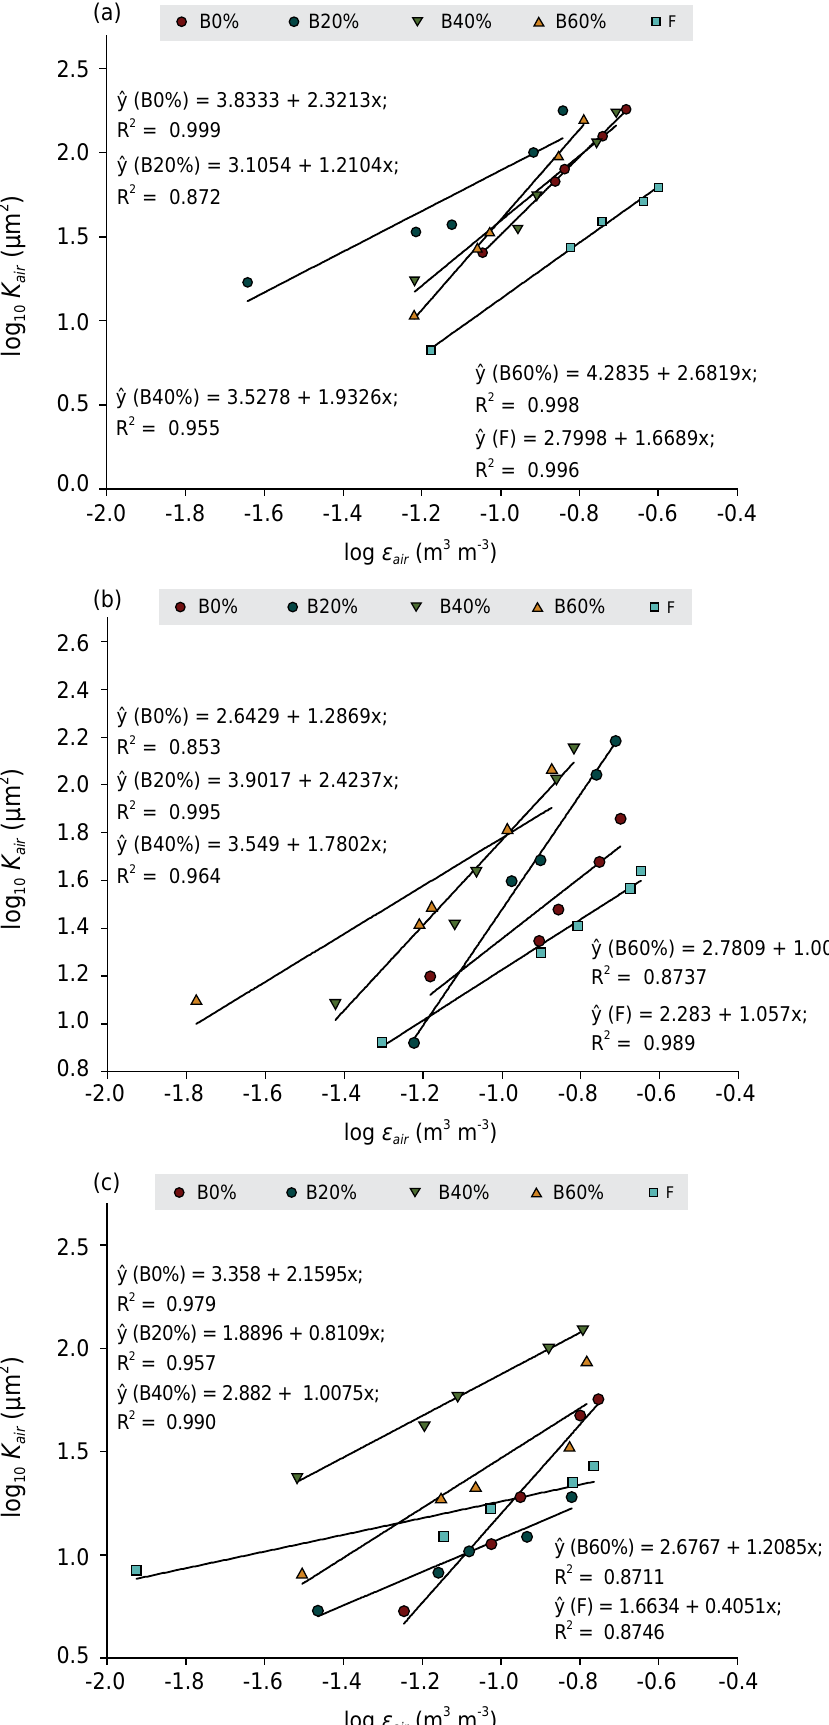
Figure 3. Logarithmic relationship between soil air permeability ( K air ) and aeration porosity ( ɛ air ) for areas under fig cultivation and secondary native forest in the layers of 0.0-0.1 m (a), 0.1-0.2 m (b) and 0.2-0.3 m